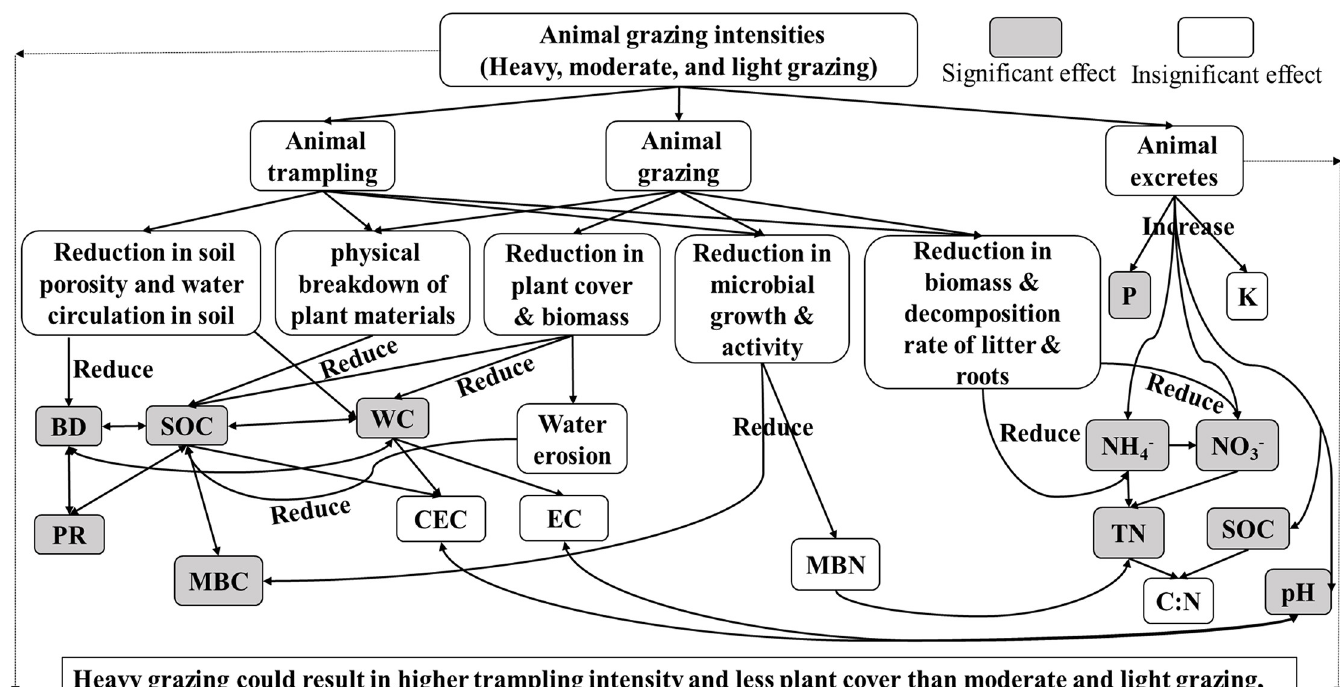
Fig 4. Proposed livestock grazing impacts on the 15 soil